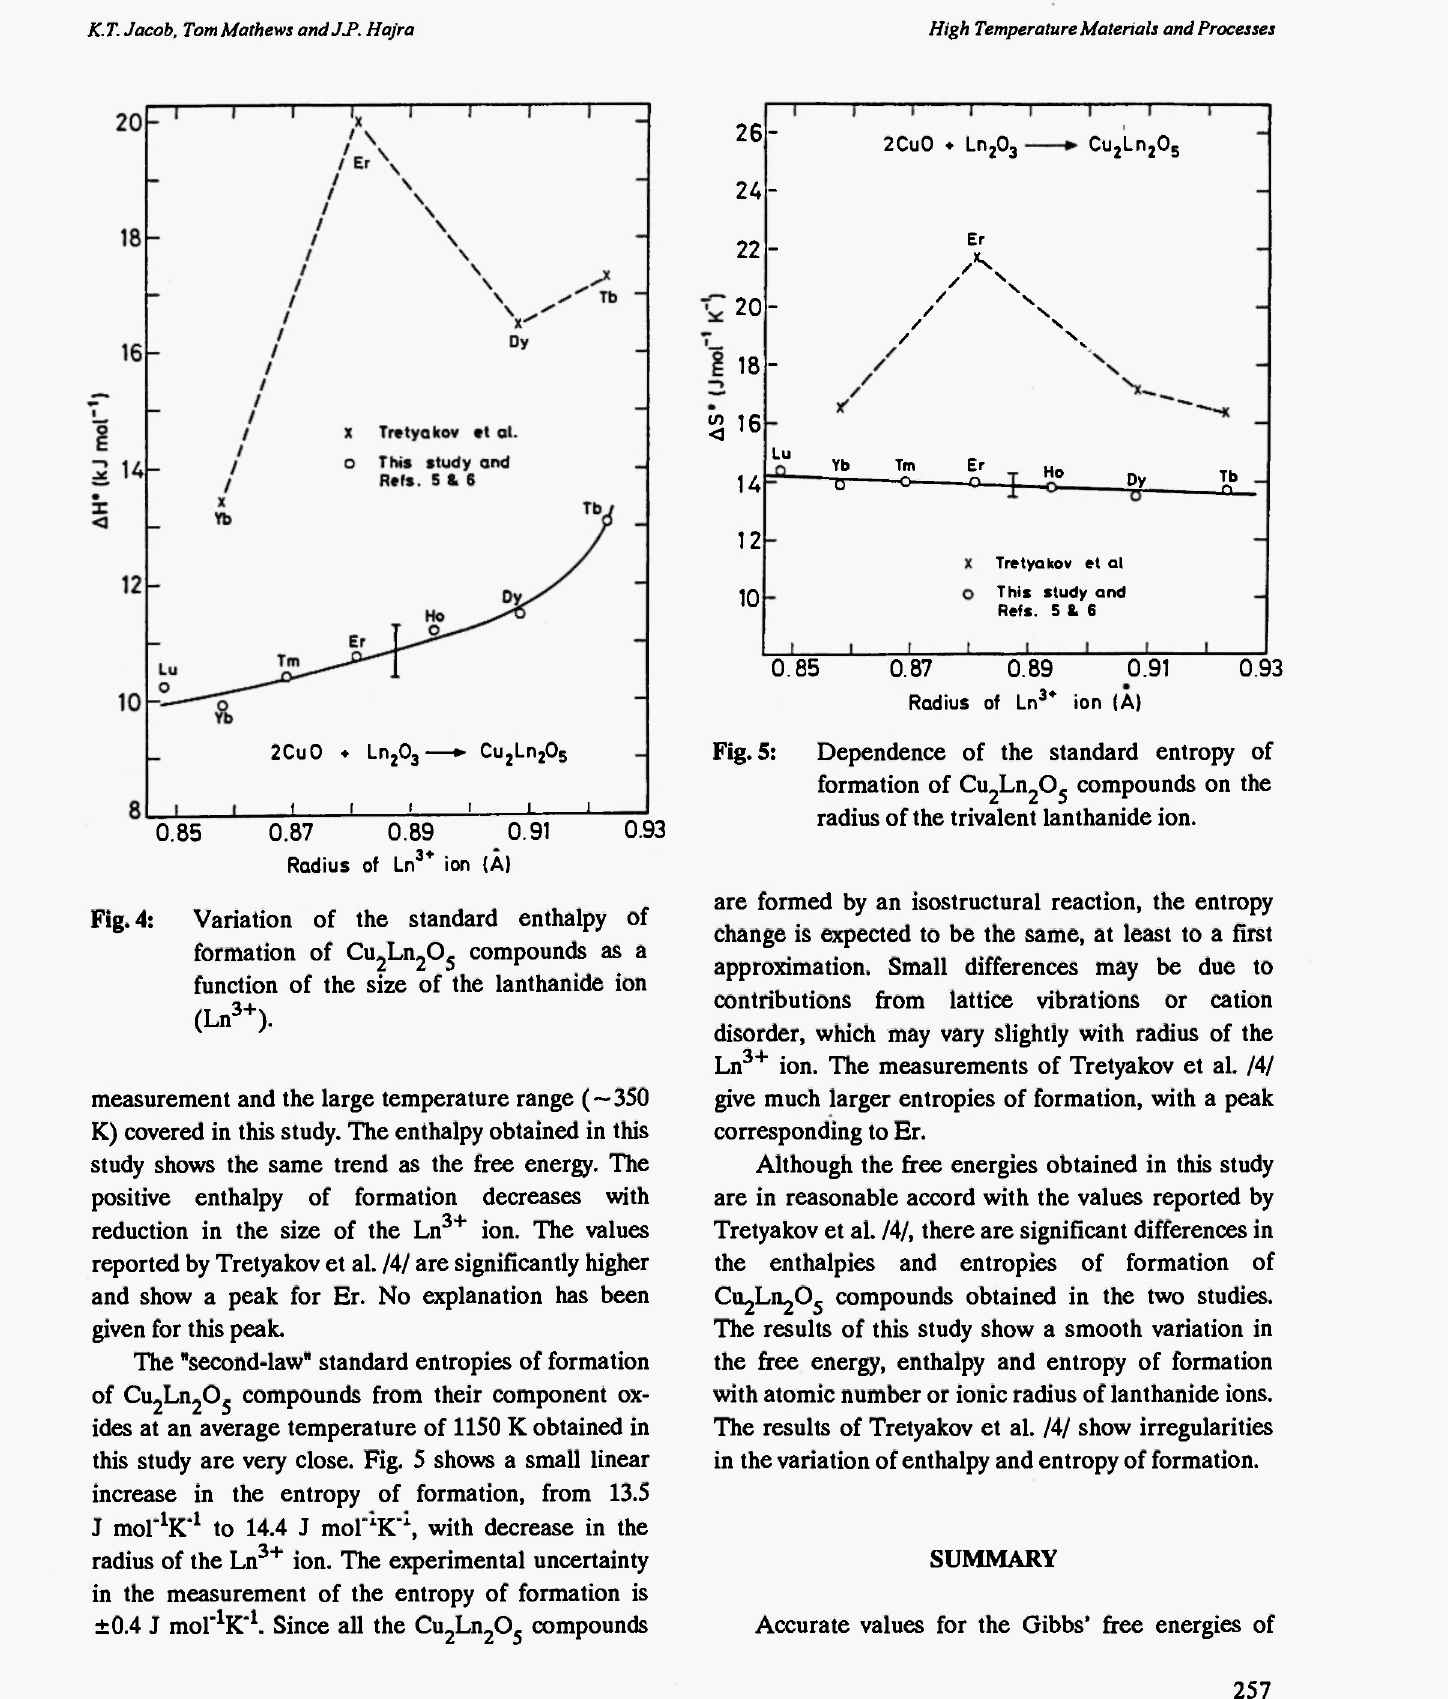
from lattice vibrations or